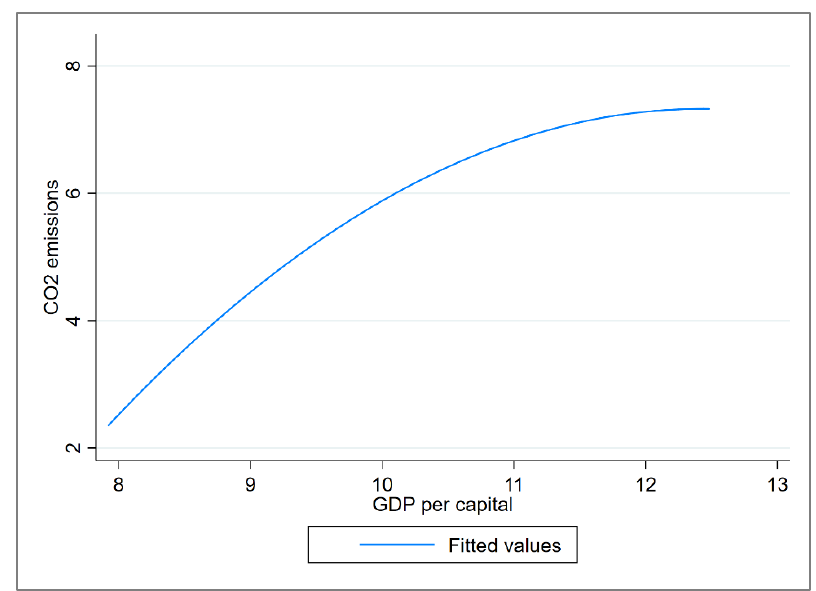
equations in Table 2, the threshold values to measure the level of economic development are obtained as RMB 10,269 and RMB 40,854.